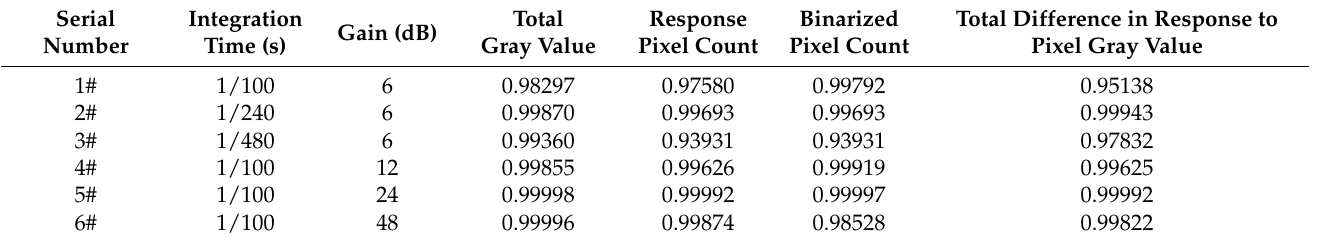
Table 4. Error analysis of fitting results of characteristic values under different conditions in dark irradiation chamber.